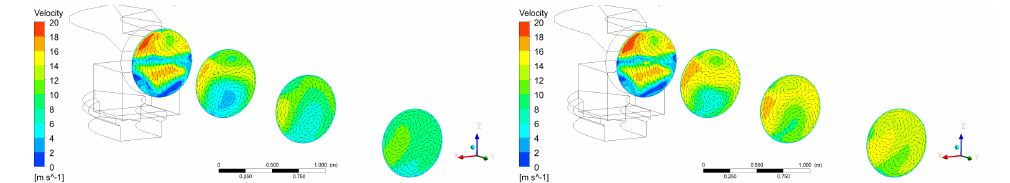
Figure 9. Velocity contours with tangentially projected velocity vectors at four transversal planes downstream the kiln, with hot gas flow to the left and combustion to the right. Figure adapted from [29].